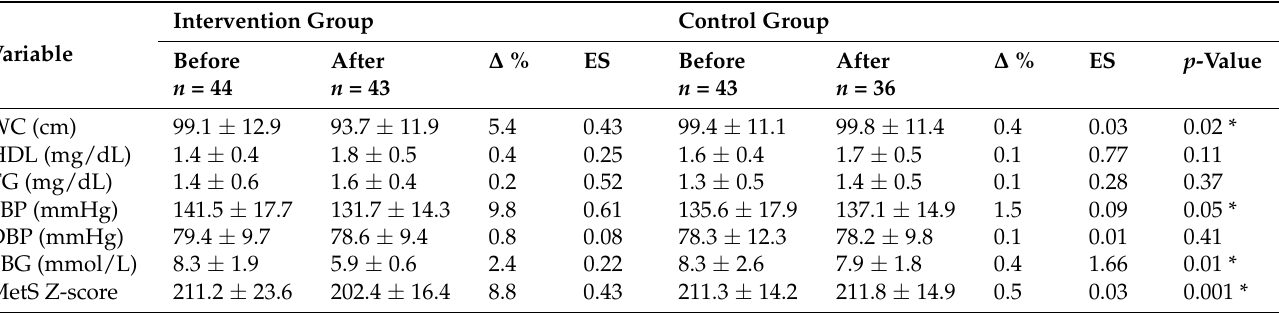
Table 2. Effect of PA on metabolic syndrome markers.